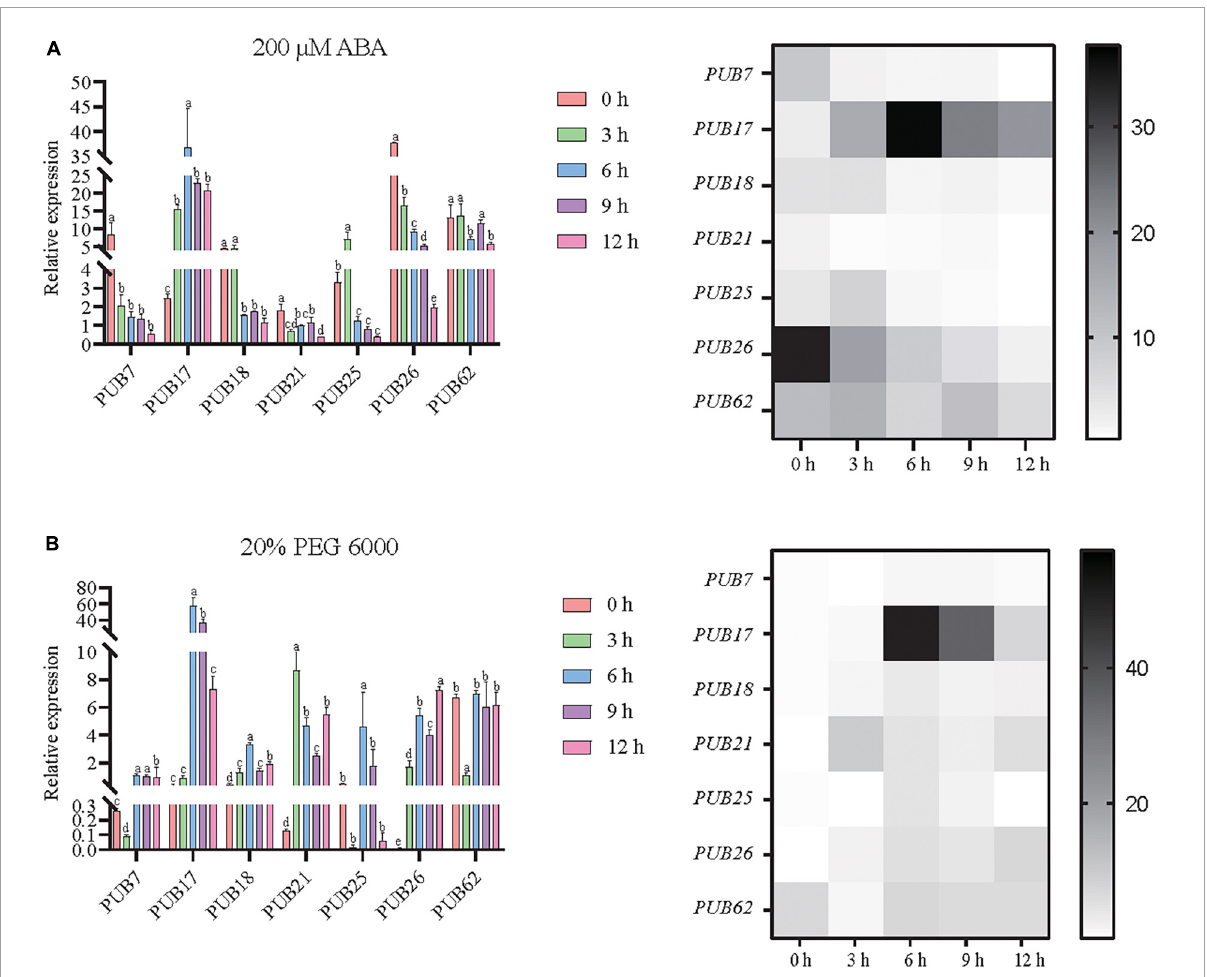
FIGURE9 Potential responses of seven sorghum U-box genes to drought. All seven selected sorghum PUB genes ( SbPUB7 , SbPUB17 , SbPUB18 , SbPUB21 , SbPUB25 , SbPUB26 , and SbPUB62 ) showed obvious expression differences under different conditions in heatmaps, and contain numerous drought elements. (A) Expression patterns of these genes in response to ABA-induced physiological drought. (B) Expression patterns of these genes in response to physiological drought induced by PEG 6000. Different lowercase letters indicate a significant difference determined by the Duncans new multiple range test ( P -value <